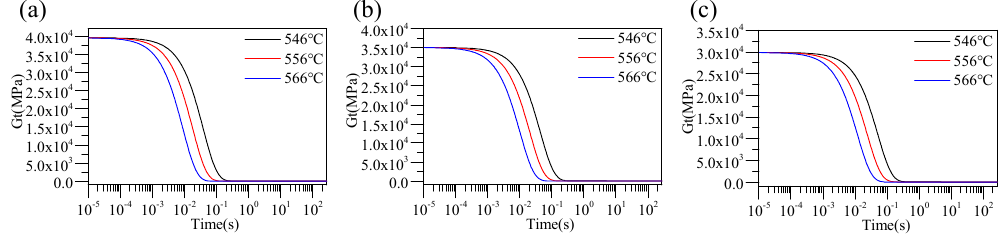
Figure 9. Diagram of the shear relaxation: ( a ) Test 1 (E 0 = 97450 MPa); ( b ) Test 2 (E 0 = 86510 MPa); ( c ) Test 3 (E 0 = 73670 MPa).